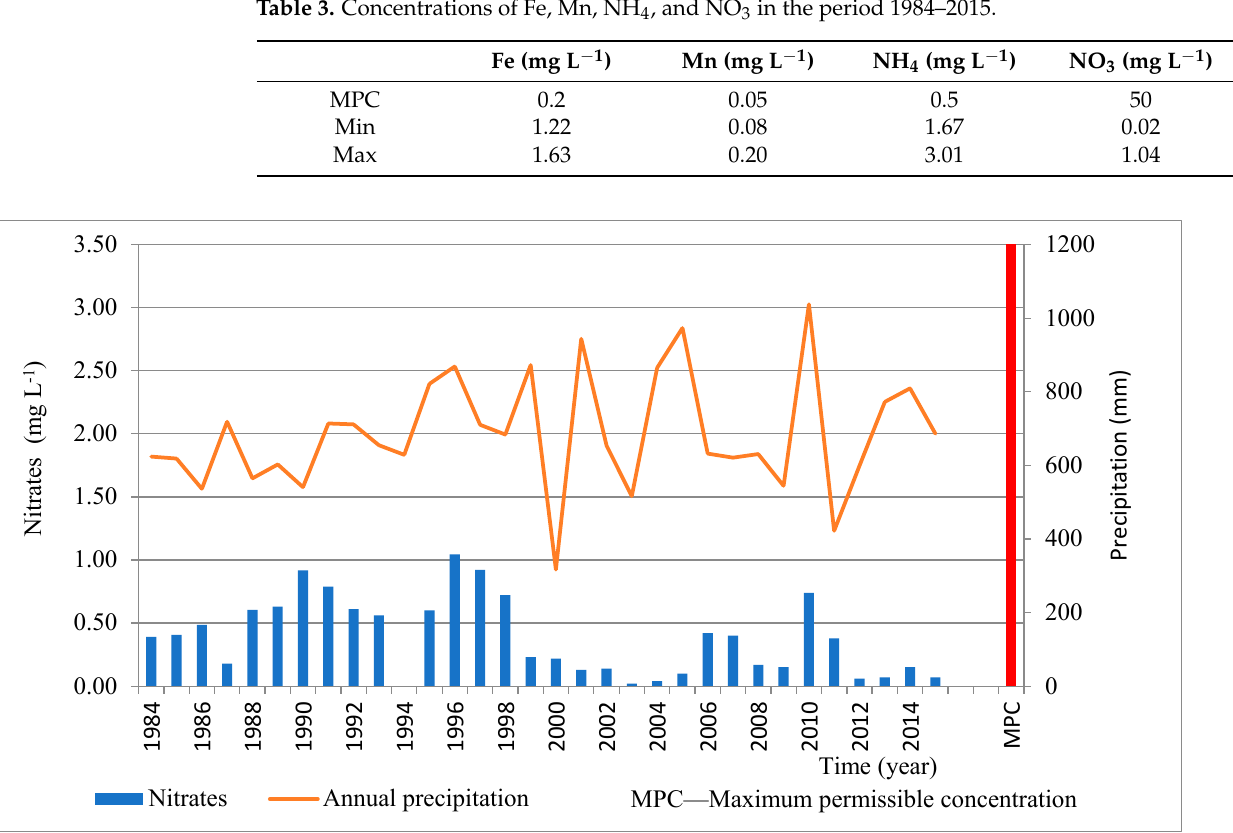
Figure 16. Nitrate concentrations in groundwater sampled at the Vinogradi Pumping Station, Osijek, Croatia in the period